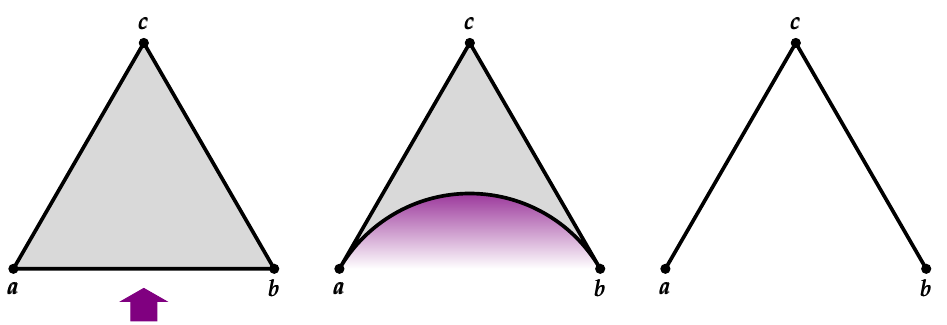
Figure 7. The edge ab is squashed until the triangle reduces to two edges.